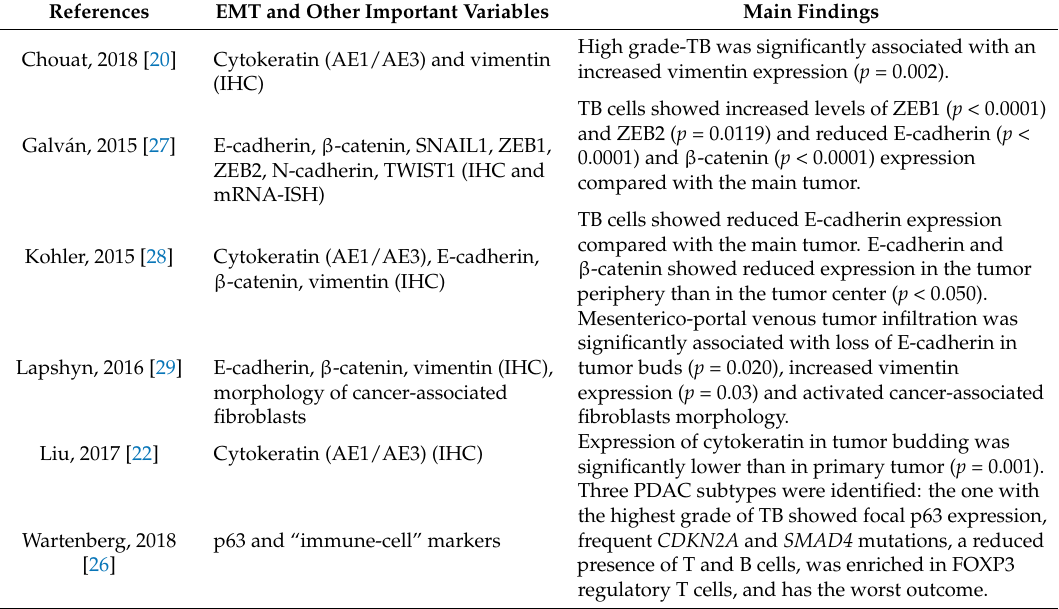
Table 2. Studies that analysed EMT and TB in pancreatic ductal adenocarcinoma, with their main